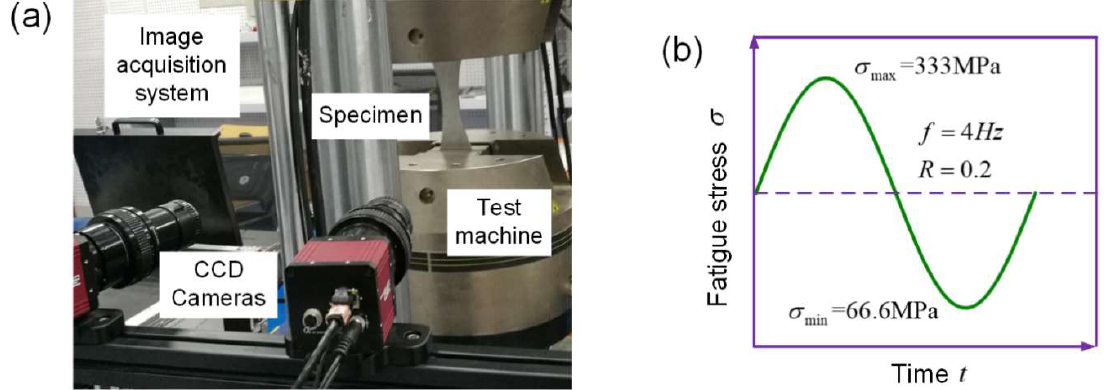
Figure 3. ( a ) Experimental set-up for fatigue tests on aluminum alloy, ( b ) applied fatigue stress waveform.